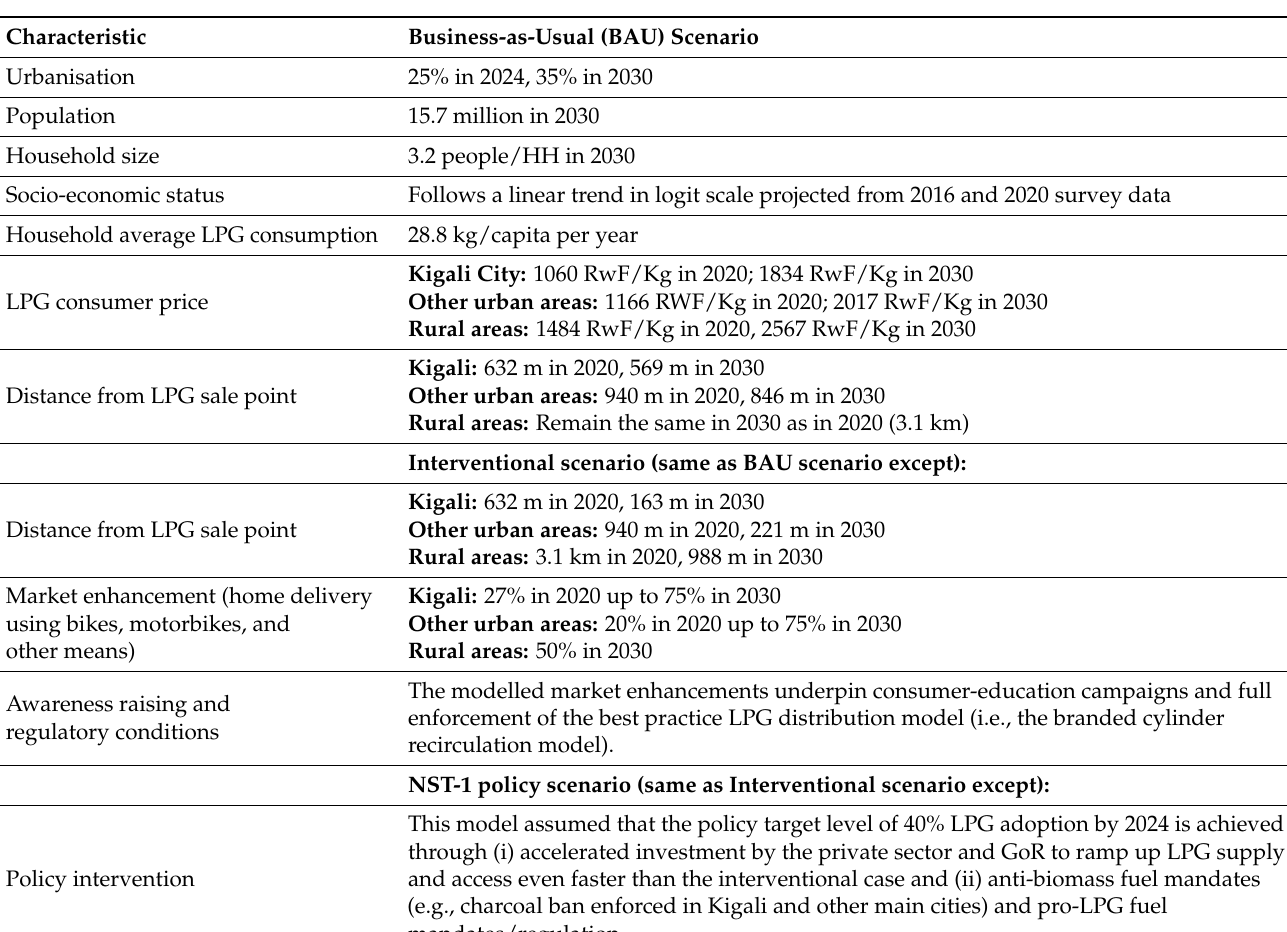
Table 1. Data informed assumptions and assumed interventions used to model the three liquefied petroleum gas (LPG) adoption scenarios in the residential sector based on available routine